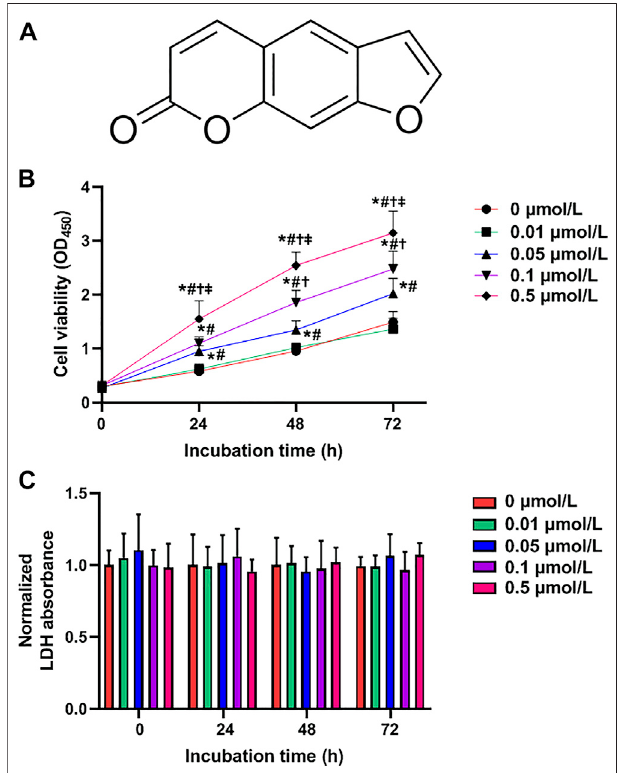
FIGURE1 | Psoralen enhances HTR-8/SVneo cell viability. (A) Chemical structure of psoralen. Cell viability (B) and LDH release (C) of HTR-8/SVneo cells after exposure to different concentrations (0, 0.01, 0.05, 0.1, and 0.5 μ mol/L) of psoralen for 0, 24, 48, and 72 h. Values are mean ± SD. Experiments were performed in triplicate and repeated three times. * p < 0.05 vs. 0 μ mol/L; # p < 0.05 vs. 0.01 μ mol/L; † p < 0.05 vs. 0.05 μ mol/L; ‡ p < 0.05 vs. 0.1 μ